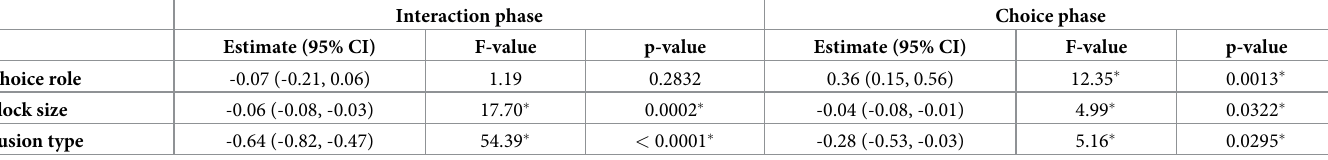
Table 1. Response rate results for male-male